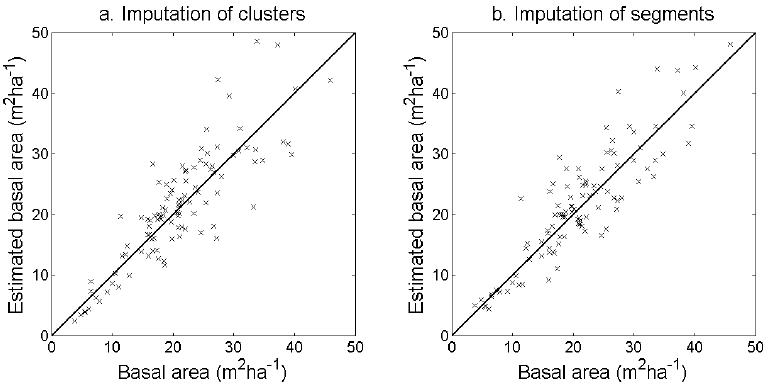
Figure 12. Basal area at plot level estimated from ( a ) imputation of clusters with model Cluster1 and ( b ) imputation of segments with model Segment1.